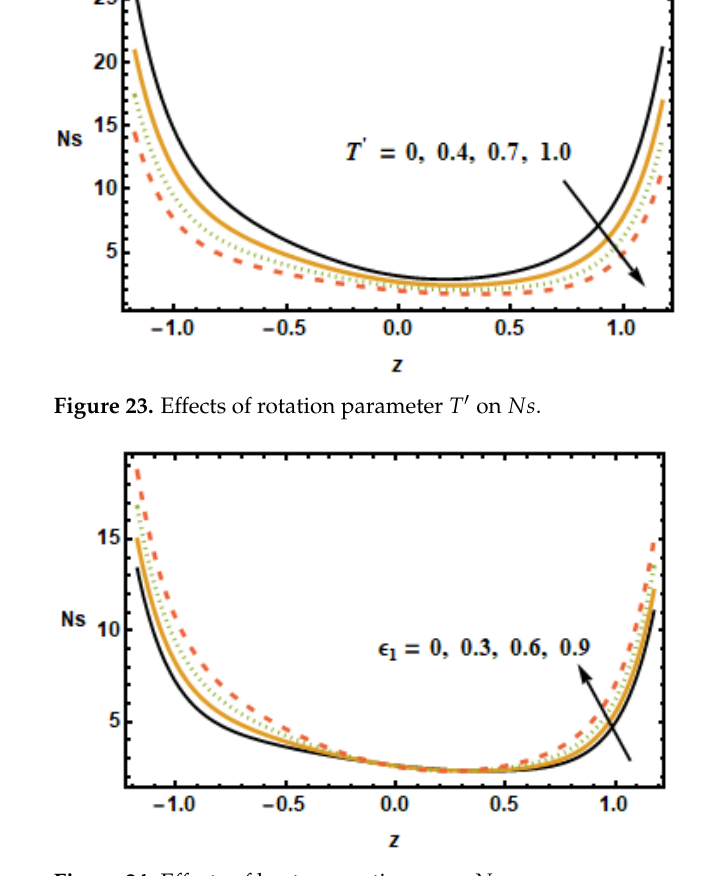
Figure 24. Effects of heat generation ε 1 on Ns